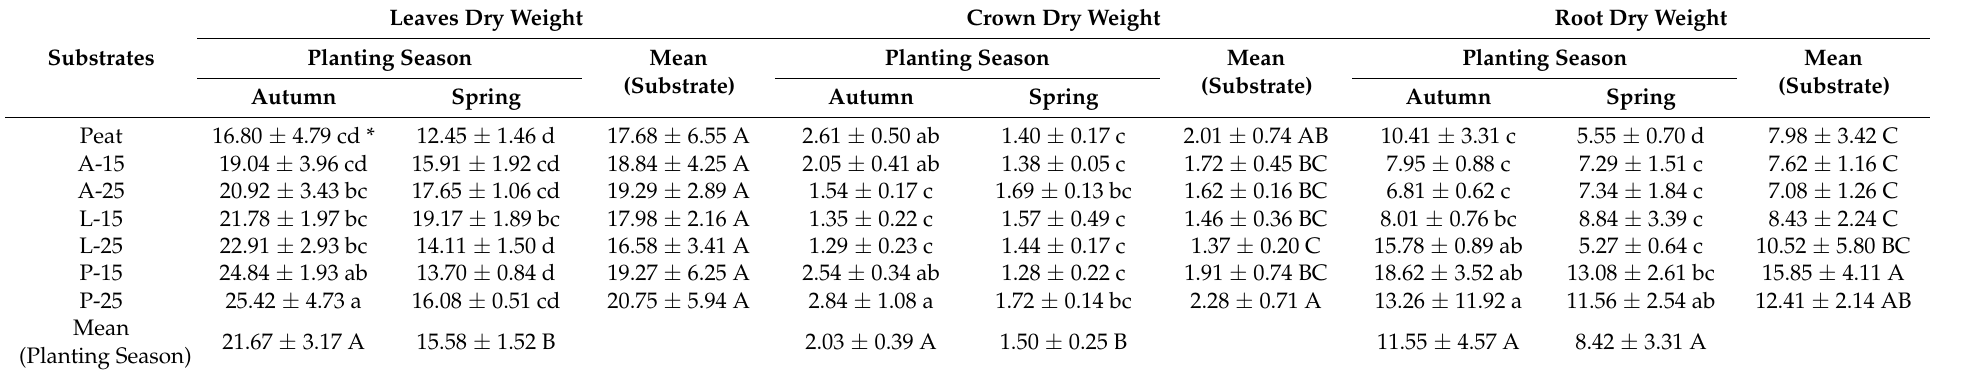
Table 10. Dry matter distribution (g) in strawberry plant parts as influenced by substrates and planting season. Leaves Dry Weight Crown Dry Weight Root Dry Weight Planting Season Mean Planting Season Mean Planting Season Mean Substrates (Substrate) (Substrate) (Substrate) Autumn Spring Autumn Spring Autumn